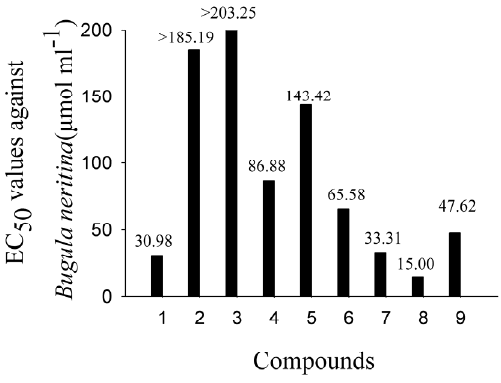
Figure 2. EC values of Compounds 1 – 9 against larval settlement of B. neritina 50